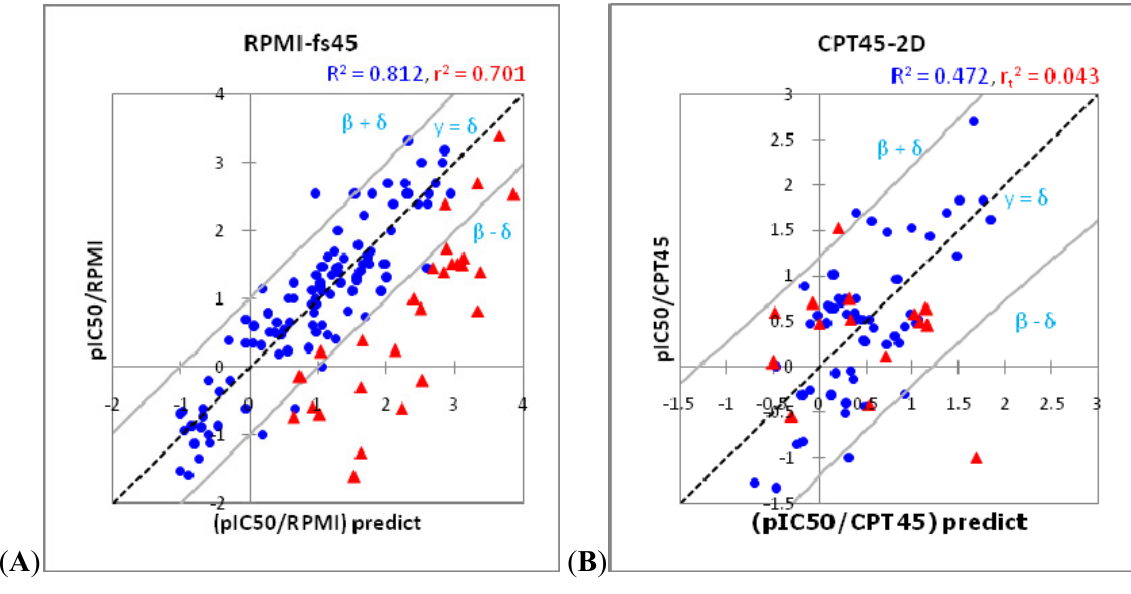
Figure 3. The relationship between observed and predicted data from QSAR model and its 95% confidence interval of ( A ) RPMI8402 cell line from 3D QSAR with steric analysis fields and ( B ) CPT45 cell line from 2D QSAR. Compound of training set are in blue circle and test set in red